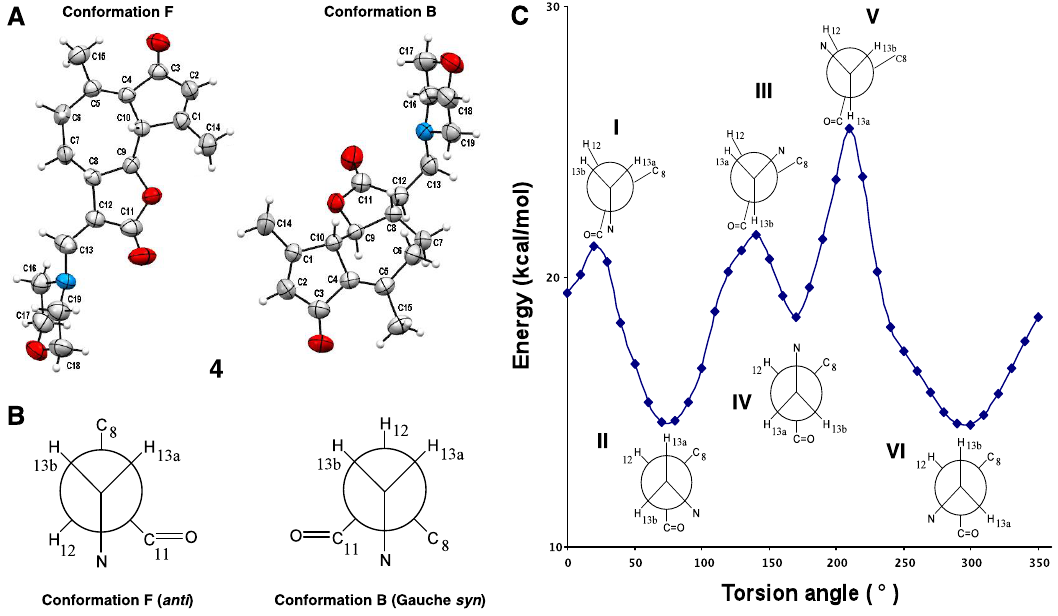
Figure 2. ( A ) 3D-ORTEP projections of the X-ray crystal structures of compound 4 with 50% probability of ellipsoids. ( B ) Conformations of compound 4 . ( C ) Conformational analysis of compound 4 , the lowest energy conformations II and VI correspond to the conformations observed in the X-ray crystal ( A ).